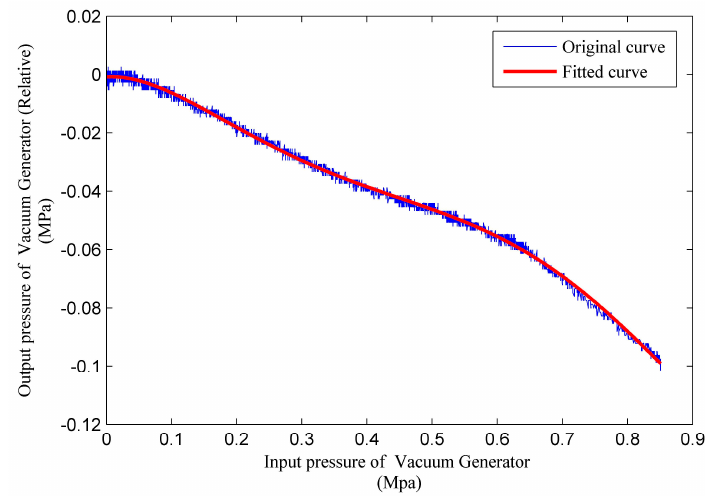
Figure 19. The characteristics of the vacuum generator used in the system of CTSA-II hand.